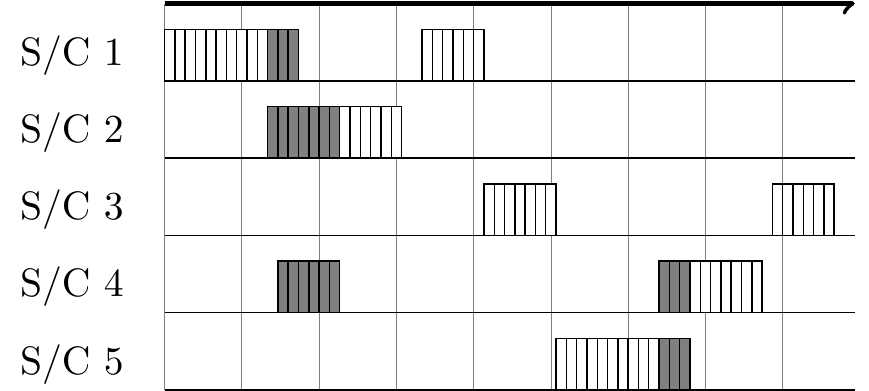
Figure 5. Simplified diagram of random channel access. Boxes indicate short bi-directional sessions with flexible or fixed lengths. Shadowed boxes indicate session frames which have